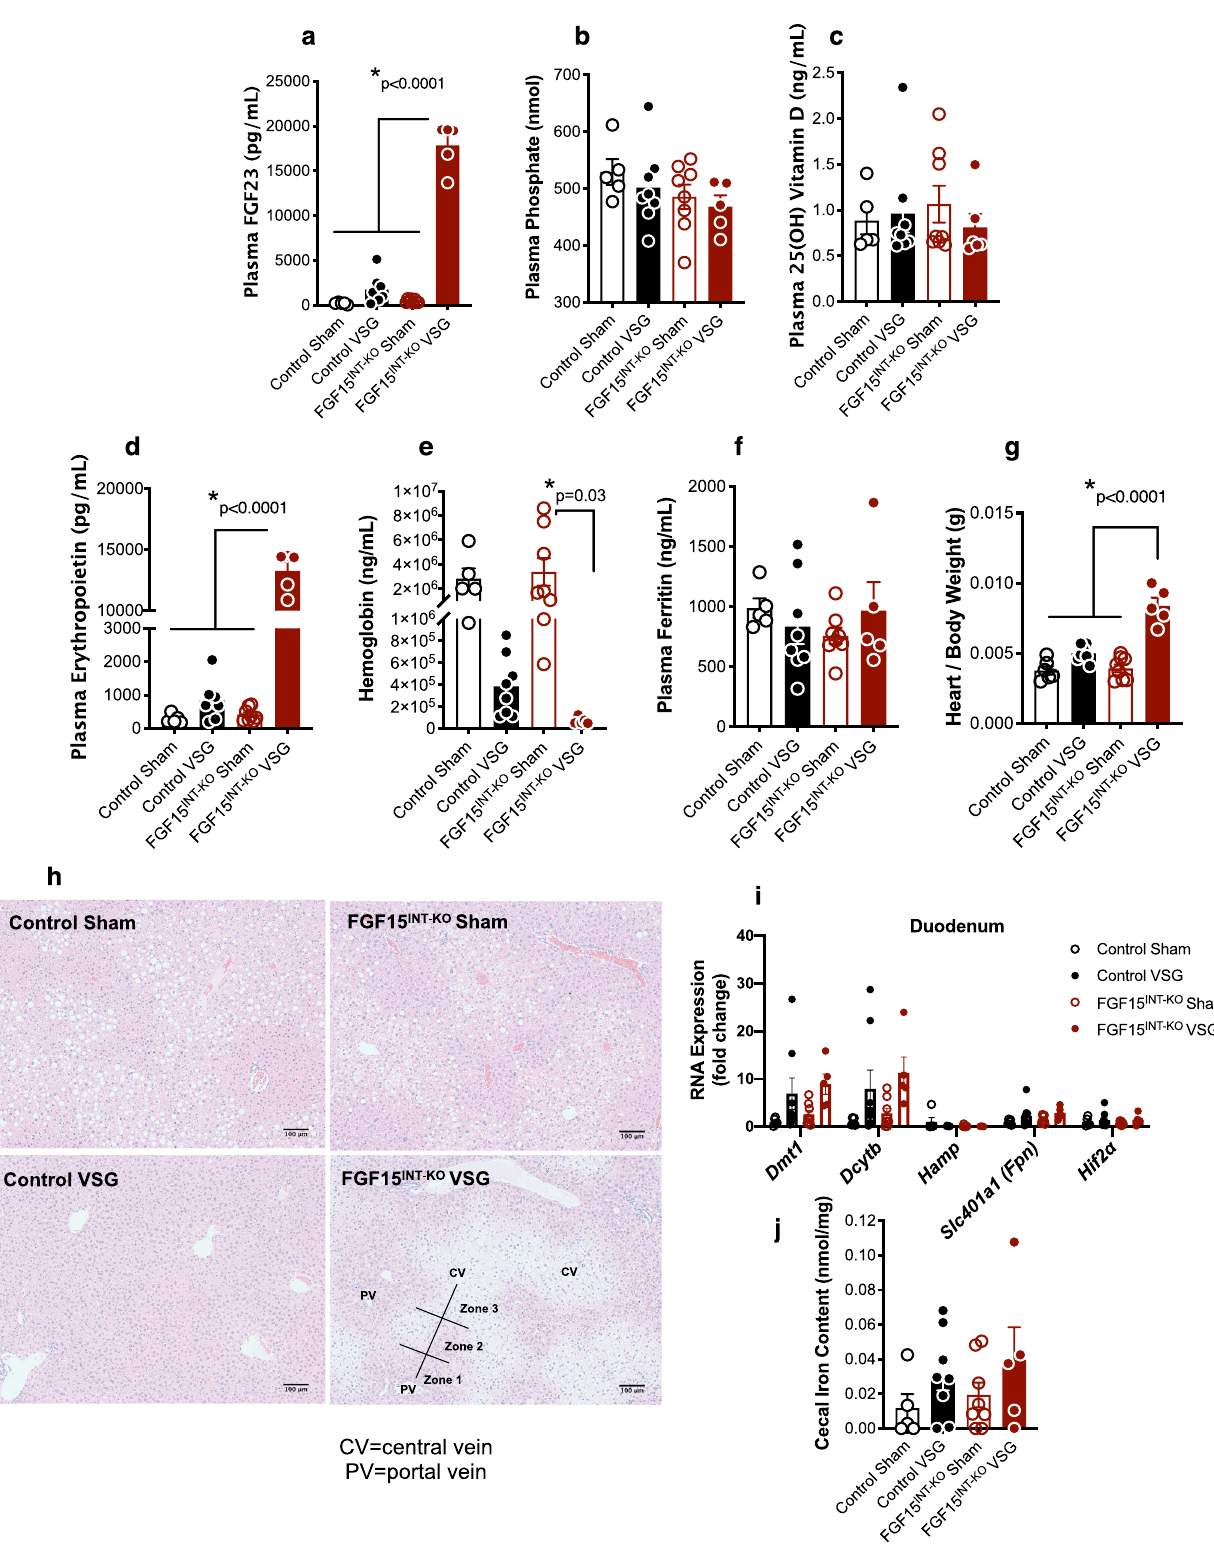
Fig. 3 Loss of intestinal FGF15 increases circulating fi broblast growth factor 23 (FGF23) and erythropoietin (EPO) levels after VSG. Plasma levels of a FGF23, b phosphate, c 25(OH) vitamin D, d erythropoietin, e hemoglobin and f ferritin. g Heart to body weight ratio. h H&E stain of liver sections, CV = central vein, PV = portal vein, Zones 1 – 3, scale bars 100 μ m. i RNA expression of Dmt1, Dcytb , Hamp , Slc401a1 (Fpn) and Hif2 α in duodenum. j Iron levels in cecal contents. Animal number for ( a – f ) and ( i , j ): Control Sham ( n = 5), Control VSG (n = 8), FGF15 INT-KO Sham ( n = 8), FGF15 INT-KO VSG ( n = 5). Animal number for g: Control Sham ( n = 6), Control VSG ( n = 8), FGF15 INT-KO Sham (n = 8), FGF15 INT-KO VSG ( n = 5). Data are shown as means± SEM. * p < 0.05 (two-way ANOVA with Tukey ’ s post hoc